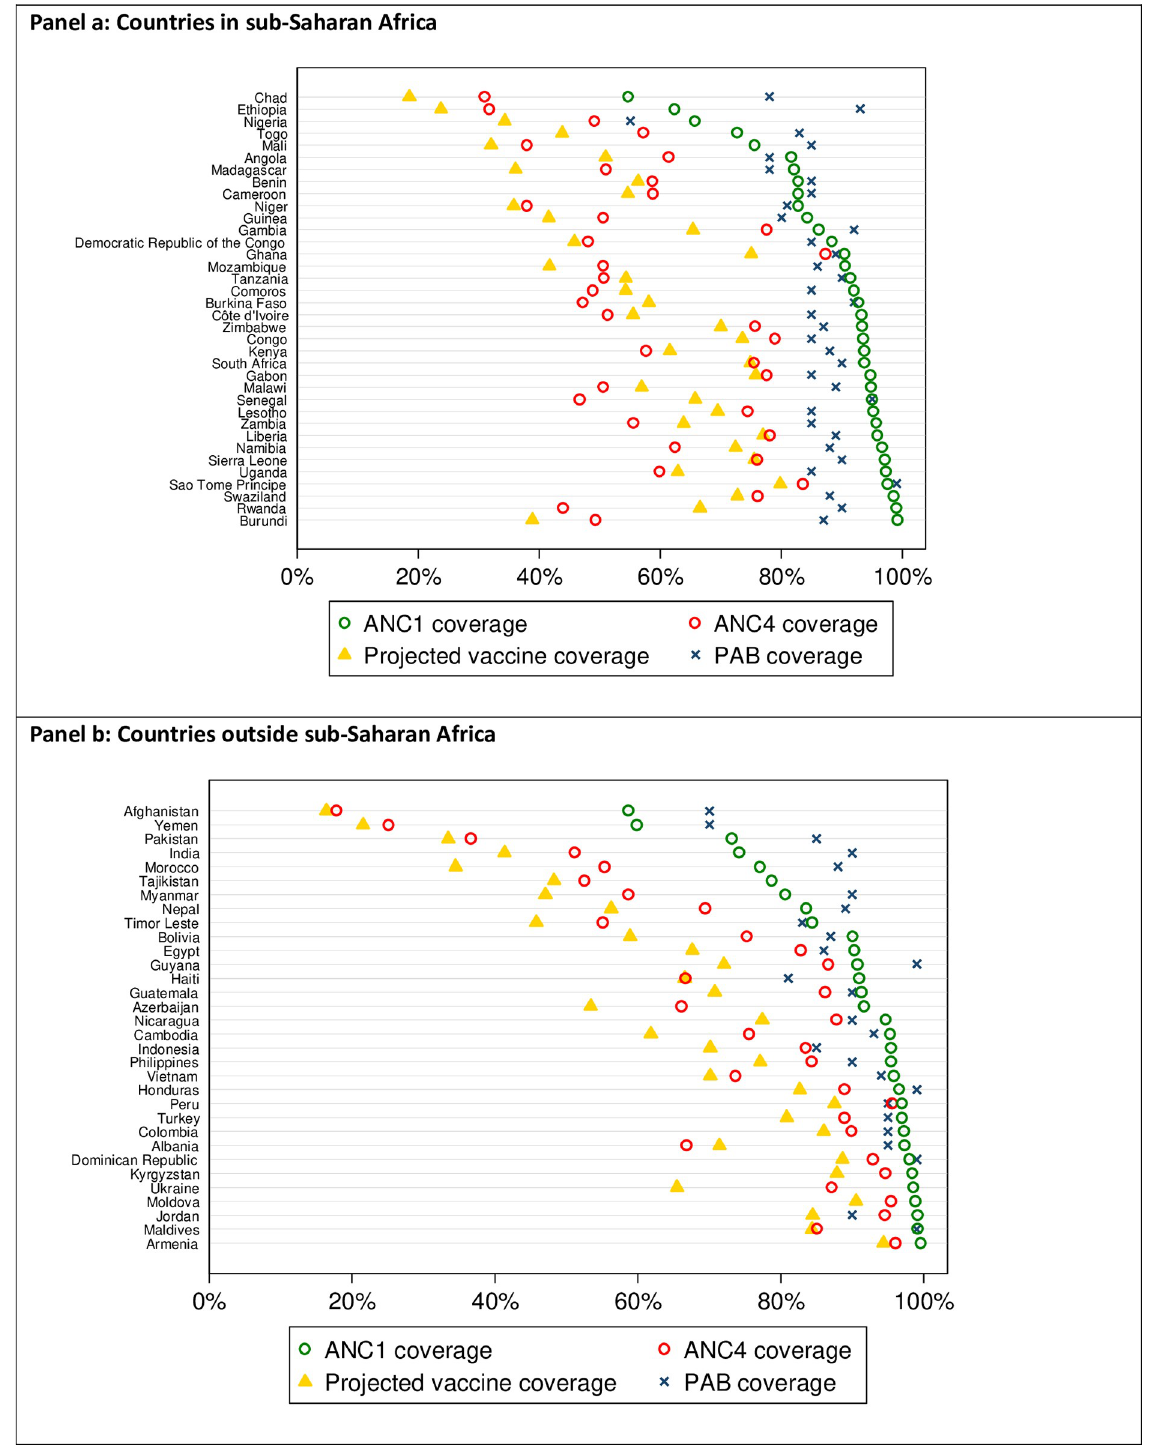
Fig 4. Comparison of RSV maternal immunization coverage predictions with estimates of ANC1, ANC4, and PAB.